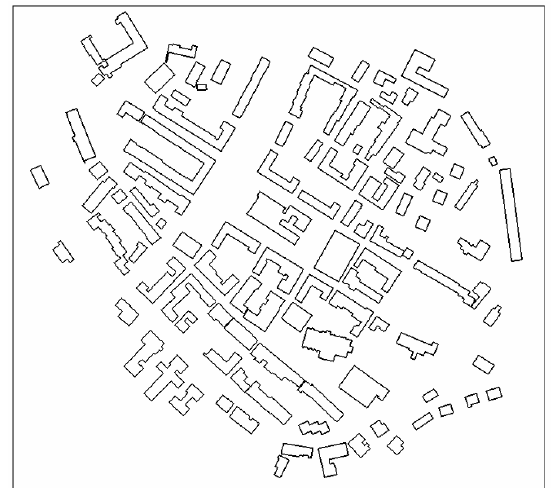
Figure 4f. Resulted outlines with an orthophoto image.